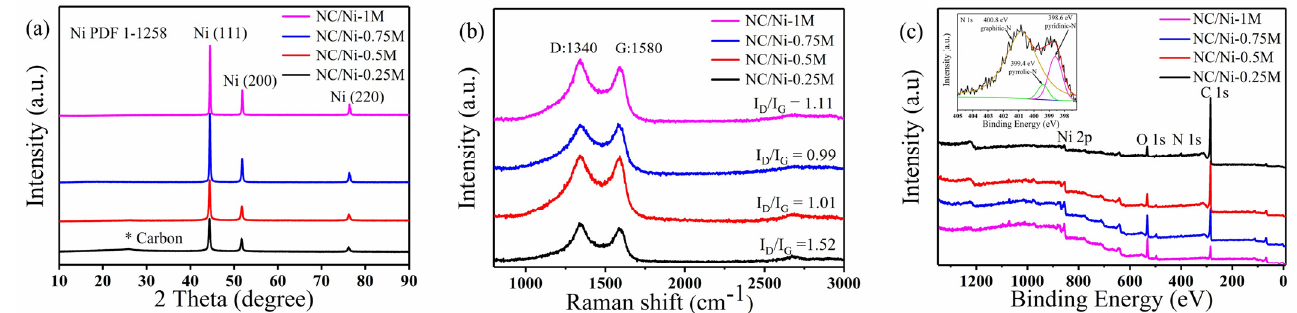
Figure 1. ( a ) The XRD, ( b ) Raman spectra and ( c ) XPS spectra of the four as-prepared NC/Ni products (the insert in ( c ) is N 1s XPS spectrum of NC/Ni-0.25M).